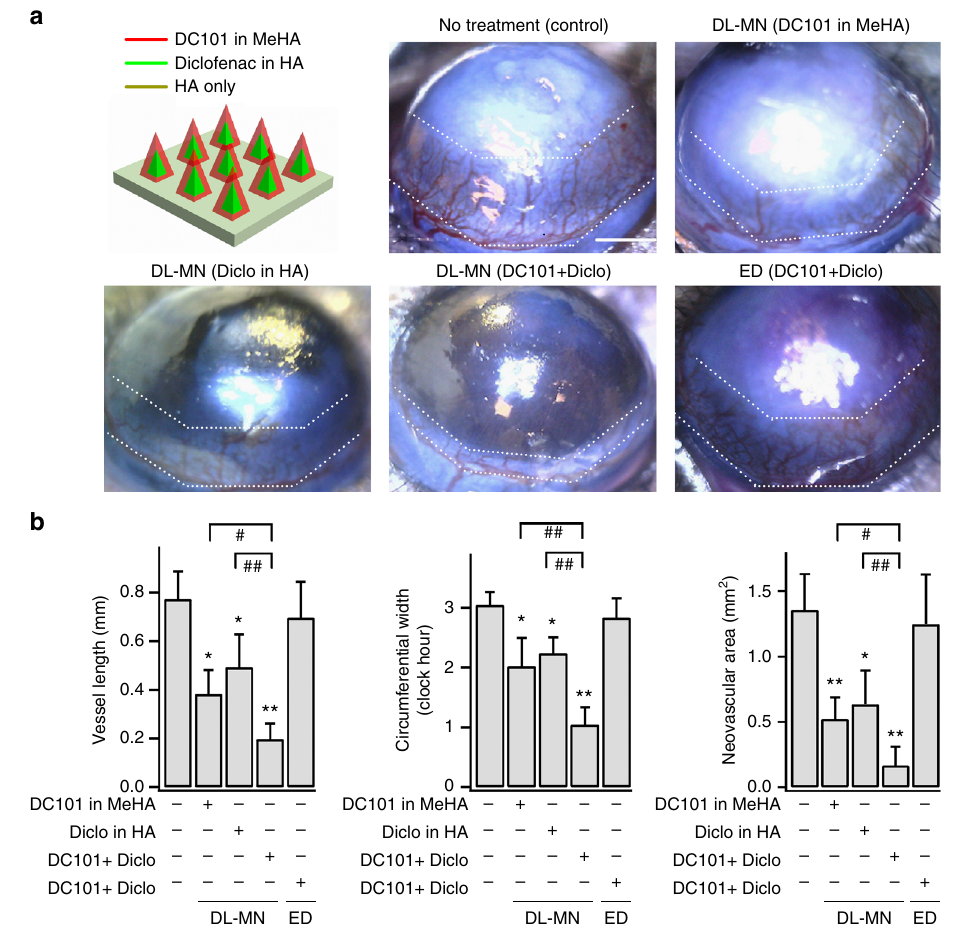
Fig. 8 Combinational therapy using DL-MN patch for synergistic effect. Mouse eyes were treated differently 2 days after being in fl icted with alkali-burn, and examined at day 7. a Illustration of drug loadings in DL-MNs, and representative images of differently treated eyes. Scale bar = 500 µ m. b Quanti fi cations of corneal neovascularization (mean ± SEM; 5 samples for each group). The white dotted lines indicate the extent of neovascular outgrowth from the limbus. Statistical comparison between groups was performed using one way ANOVA. * p < 0.05, ** p < 0.01 vs. control; # p < 0.05, ## p < 0.01 between indicated